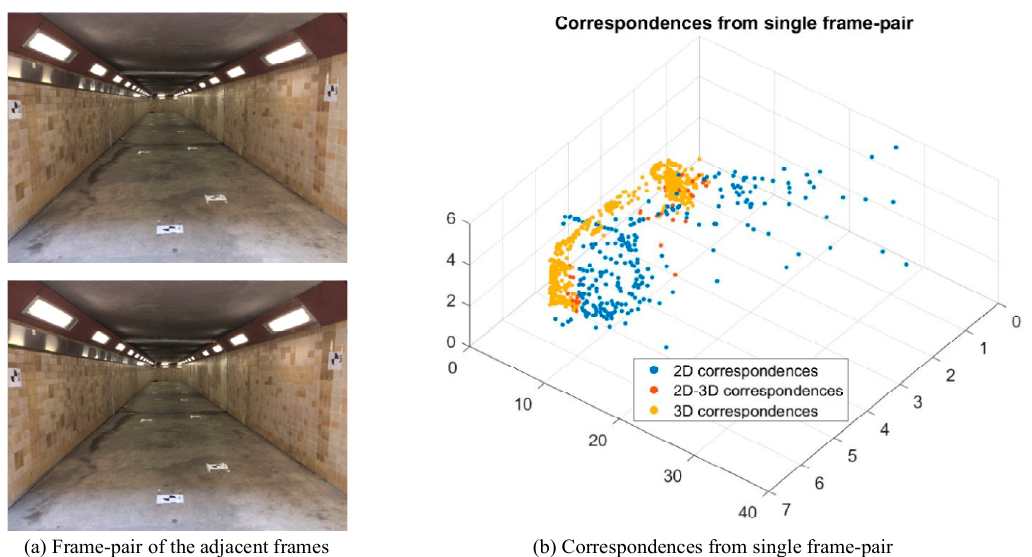
Figure 3. Correspondences identified from single frame pair.